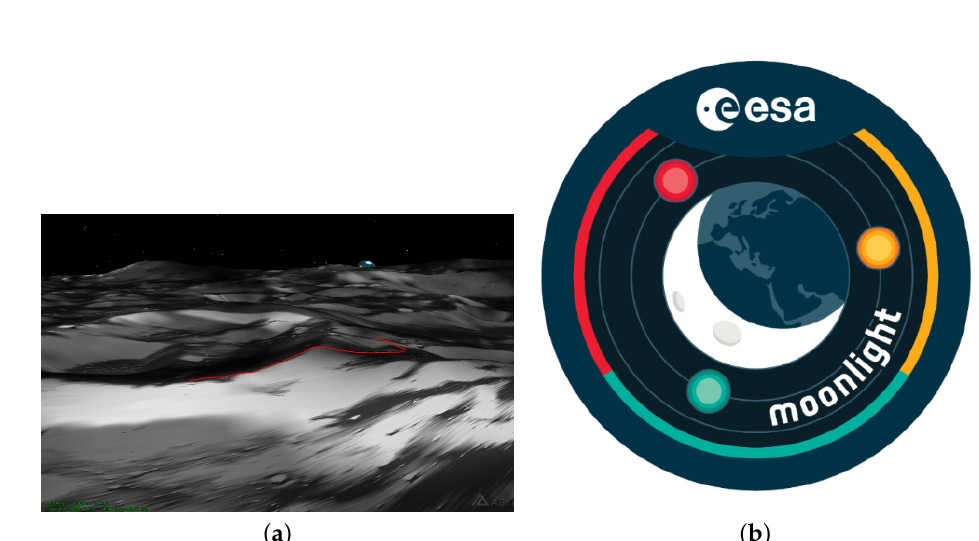
Figure 3. ( a ) Part of the lunar traverse shown in Figure 1 considered in this paper. The terrain topography shown is simulated using the high-resolution DEM provided (5 m/pixel) in the LOLA PDS archive [27]. The left part of the traverse follows the southern rim of the de Gerlache crater, while the right part descends into the direction of the Shackleton crater. ( b ) shows the Moonlight